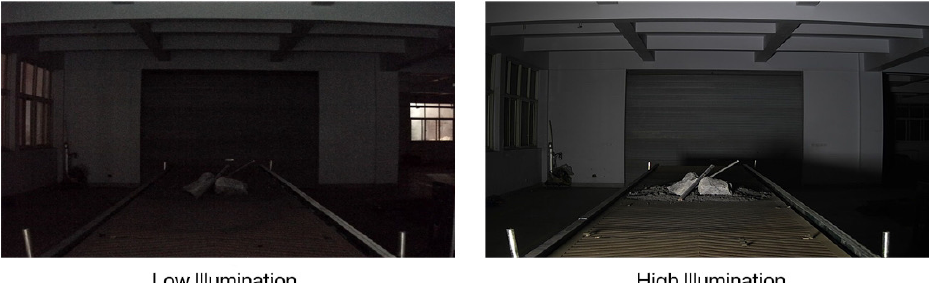
Figure 7. Different lighting images collected by the test bench.